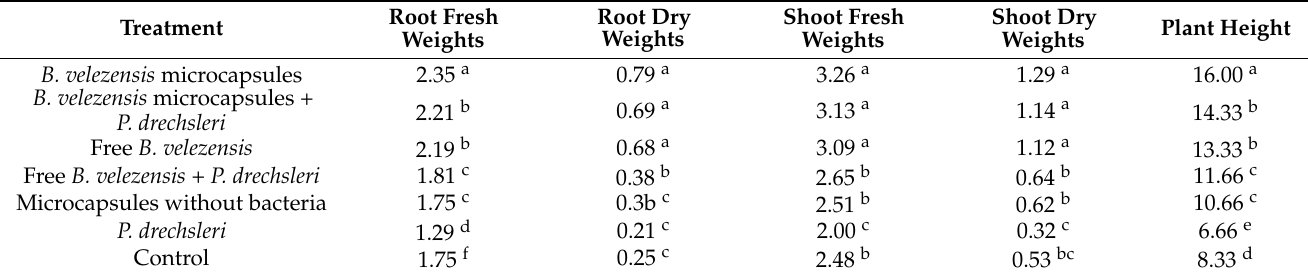
Table 2. Effects of B. velezensis inoculation as a free cell preparation and as a microencapsulated preparation on growth parameters in pistachio